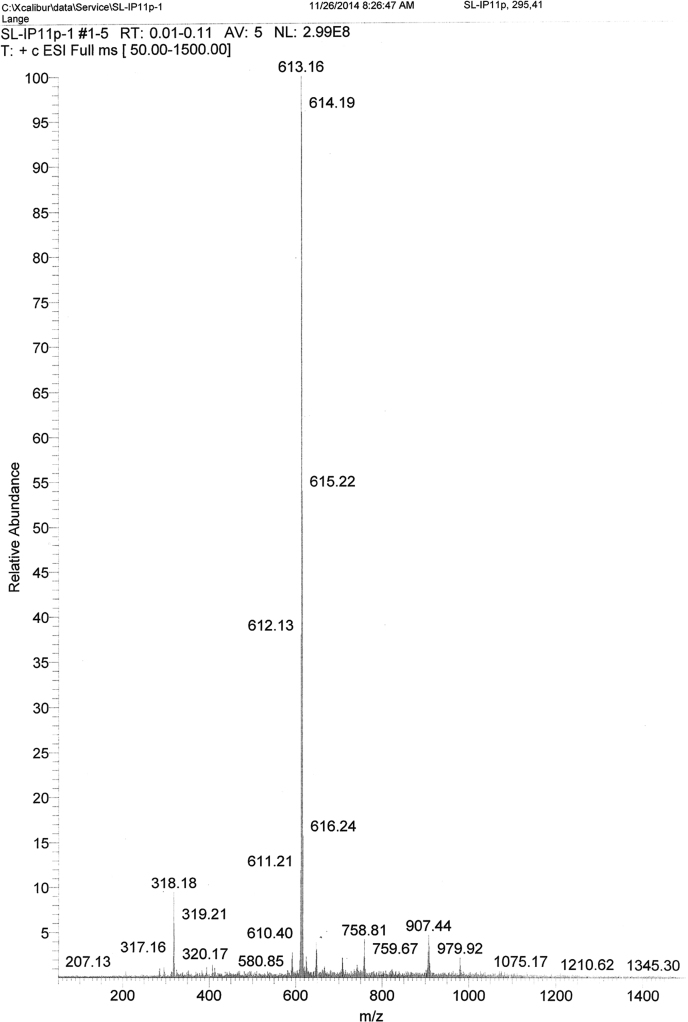
ESI-MS spectra of the purified IPMdeut. Found: 318.18 [M+Na]+, 613.16 [2M+Na]+; calcd: 318.41 [M+Na]+, 613.83 [2M+Na]+.